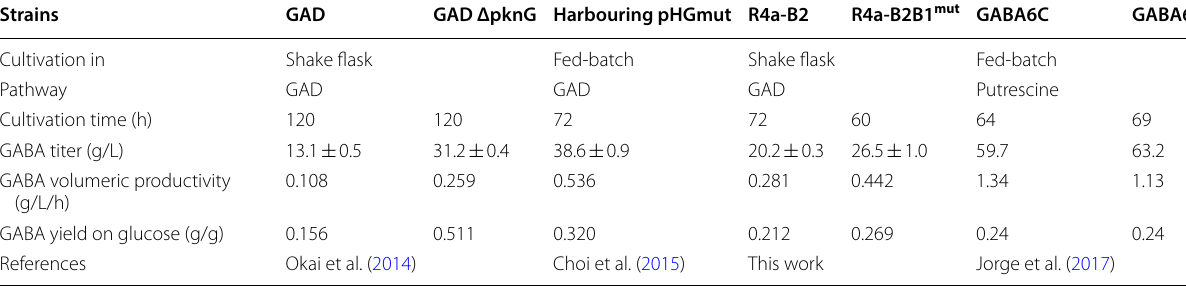
Table 3 GABA production in several recombinant C. glutamicum strains